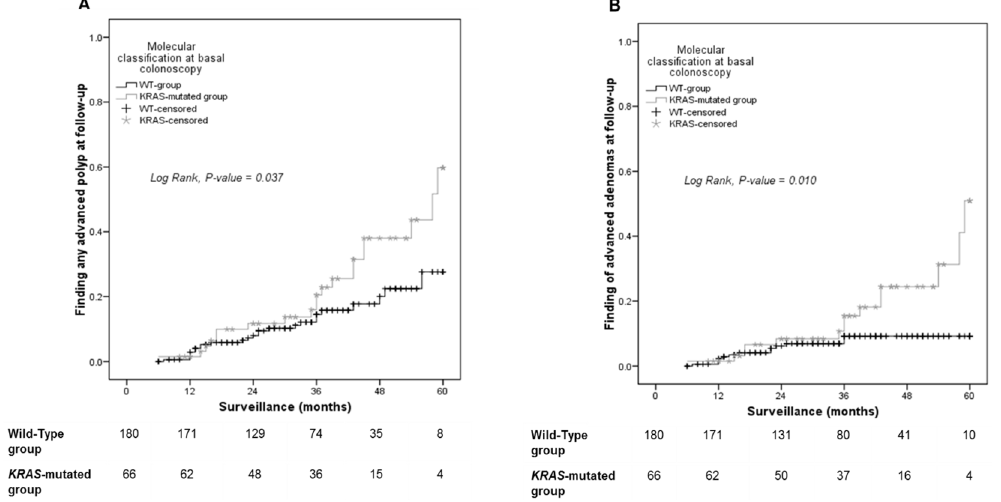
Fig 2. Risk of developing advanced polyps based on KRAS mutational status at baseline colonoscopy. Kaplan-Meier curves show the proportions of patients with WT or KRAS -mutated lesions that developedeither (A) any advancedpolyp or (B) advancedadenomas over